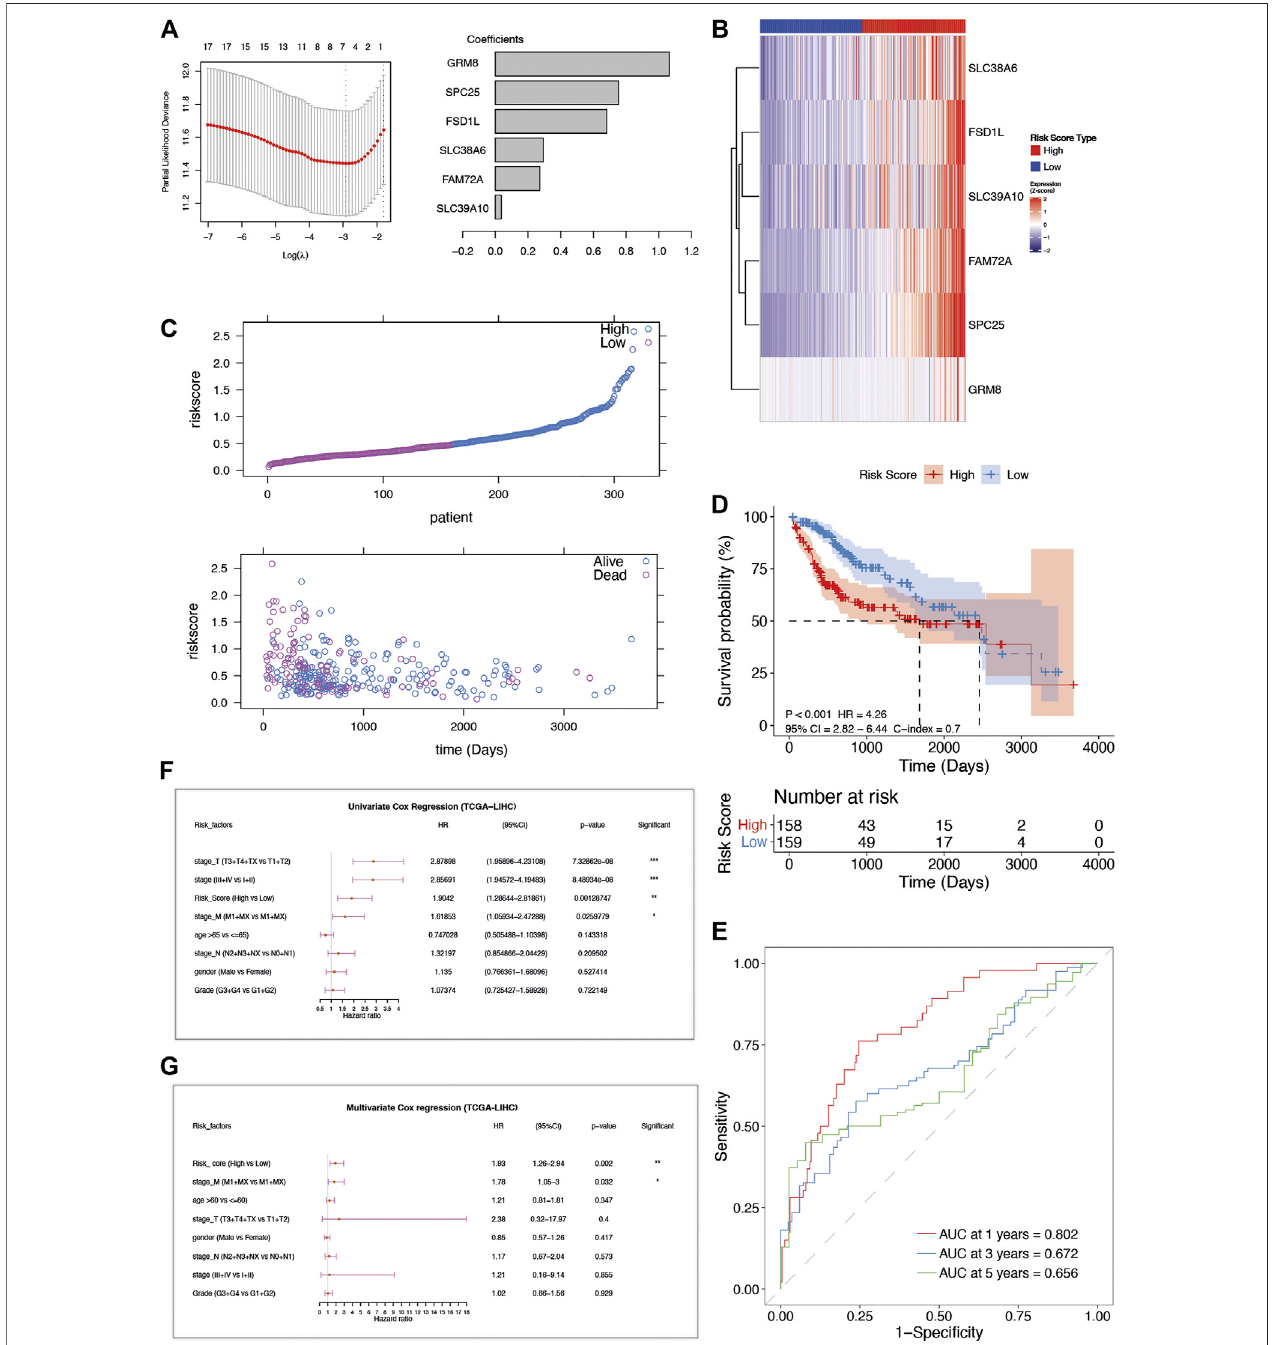
FIGURE2| Theconstructionand veri fi cationofAFs-derived prognostic modelinTCGA-LIHCcohort. (A) LASSOcoef fi cient pro fi lesoftheselected AFsgenes. (B) The heatmap of z-score transformed gene expression for the 6 selected AFs genes. (C) The risk score distribution and survival status distribution of the AFs-derived prognostic model in TCGA -LIHC cohort. (D) Kaplan – Meier OS curve with log-rank test for risk score. (E) ROC curves of the risk score in predicting 1-, 3-, and 5-years OS. (F) Univariate and (G) multivariate Cox regression analysis of risk score and clinical factors.